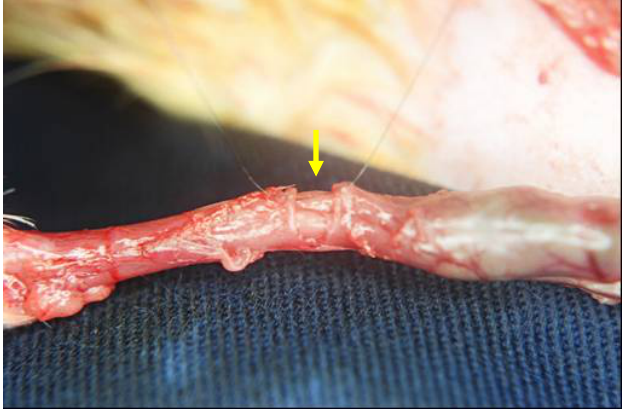
FIGURE 1 – Seromyotomy (arrow). Nylon thread attaching together the sectional seromuscular verge